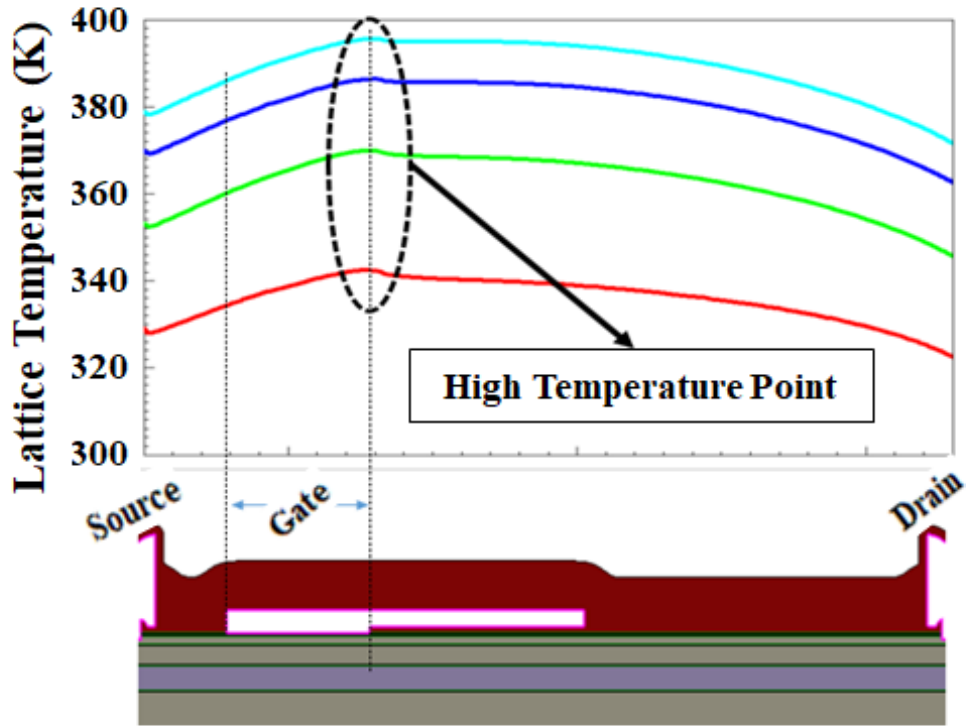
Figure 14. Simulated lattice temperature distribution at the interface of AlGaN and GaN undoped region with horizontal cutline.